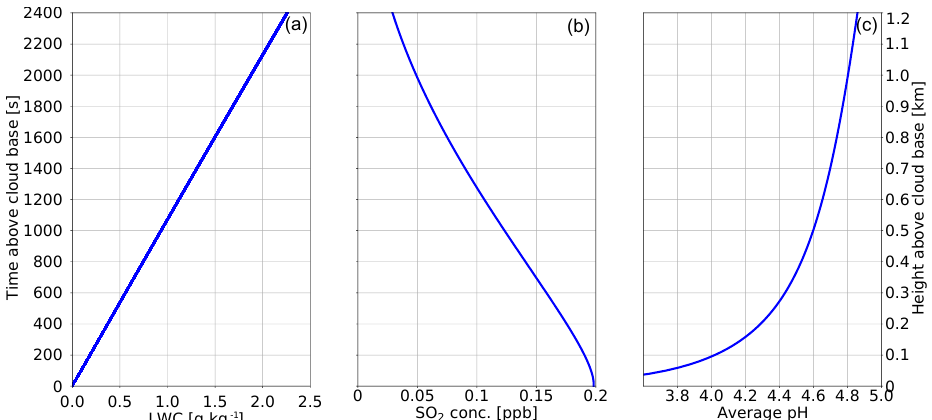
Figure 1. Physical and chemical conditions in the adiabatic parcel model. Panel (a) shows the liquid water mixing ratio (LWC), panel (b) shows the SO 2 concentration (both gas phase and dissolved), and panel (c) shows the water volume weighted average pH of the simulated population of water